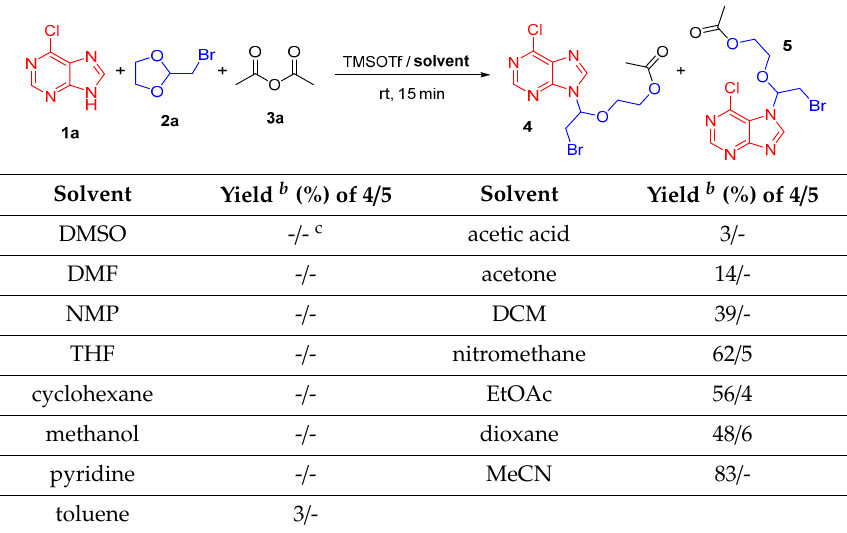
Table 2. Preparation of acyclonucleoside 4 by multi-component reaction—solvent optimization a .